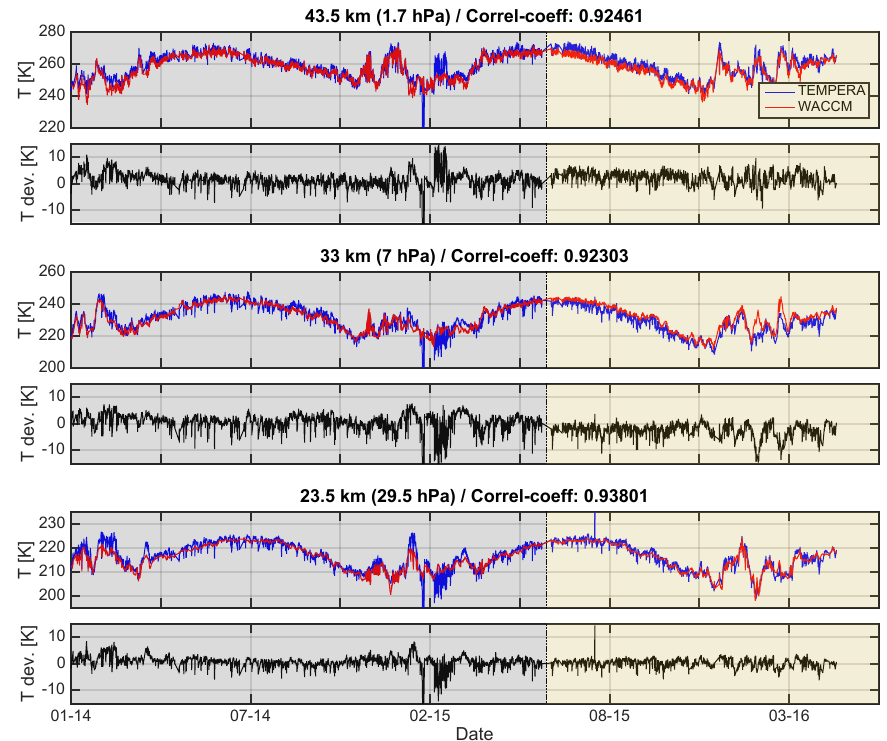
Figure 15. Stratospheric temperature evolution from TEMPERA and WACCM. Different background colours are used to distinguish between period 1 and 2 (grey and light brown,